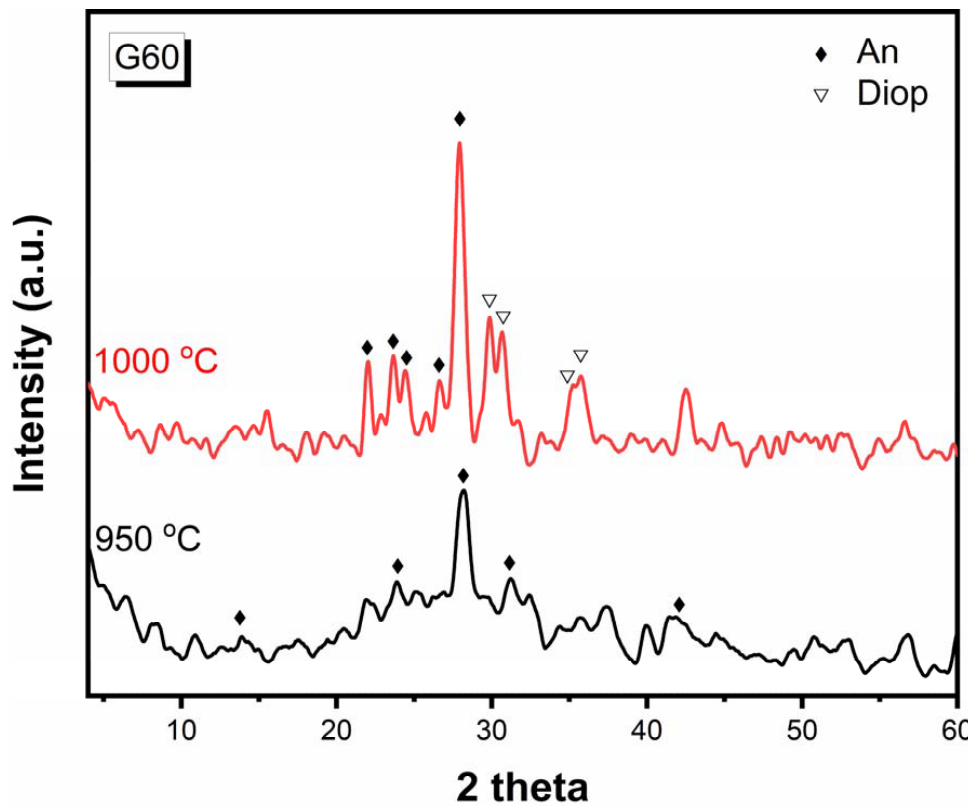
Figure 4. X-ray diffraction patterns of G60 after heat-treatment at 950 ◦ C for 2 h and 1000 ◦ C for 2 Figure 4. X ‐ ray diffraction patterns of G60 after heat ‐ treatment at 950  C for 2 h and 1000  C for 2 h.